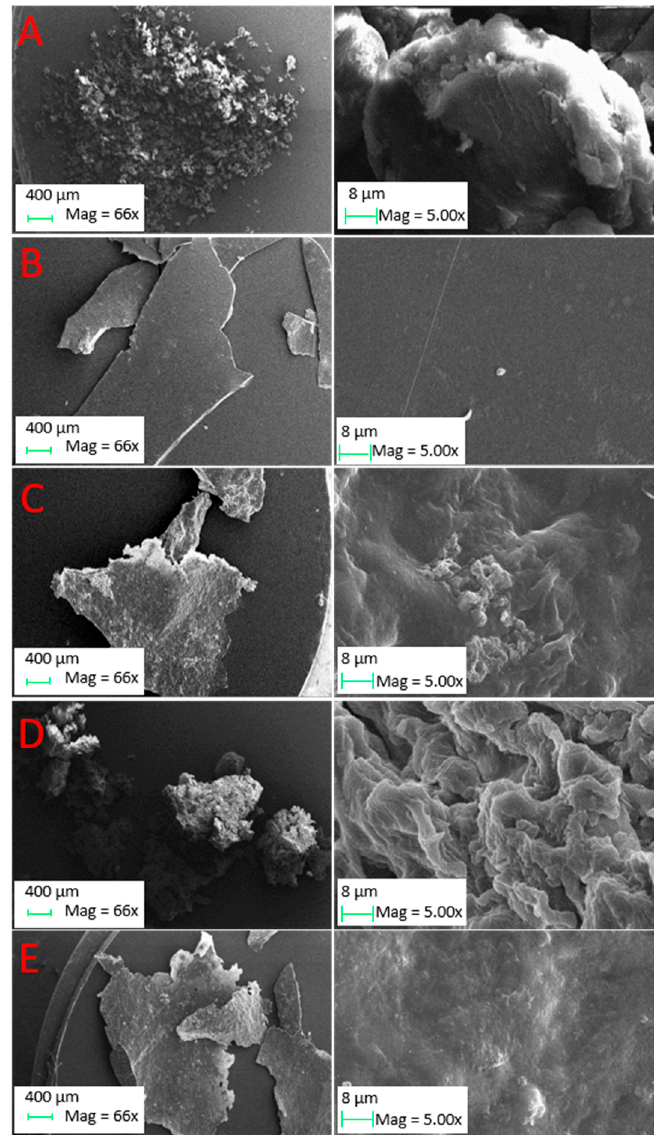
Figure 4. Low- and high-magnification SEM images for ( A ) standard commercial pectin; ( B ) “hot- water” extracted pectin in the absence (extraction 2) of and ( C ) in the presence of citric acid (extraction 4); ( D ) RSLD extracted pectin (extraction 7); ( E ) MW extracted pectin (extraction 9).